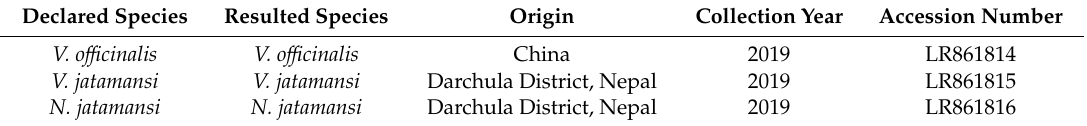
Table 1. DNA barcoding results. In the table are shown declared species, resulted species, origin, collection year and accession numbers deposited in the EMBL Nucleotide Sequence Database (www.ebi.ac.uk /